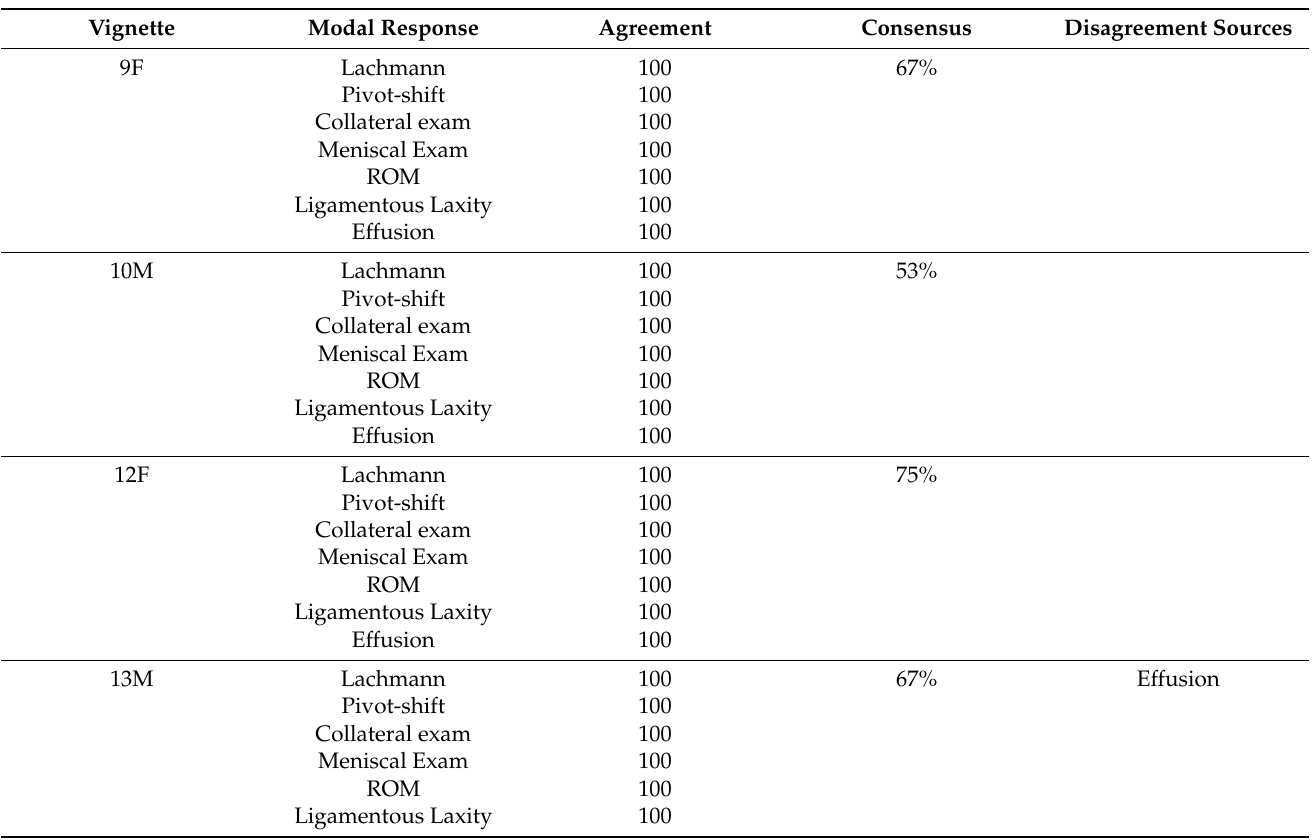
Table 2. Consensus reached in three vignettes regarding pertinent physical exam maneuvers with relevant sources of disagreement per